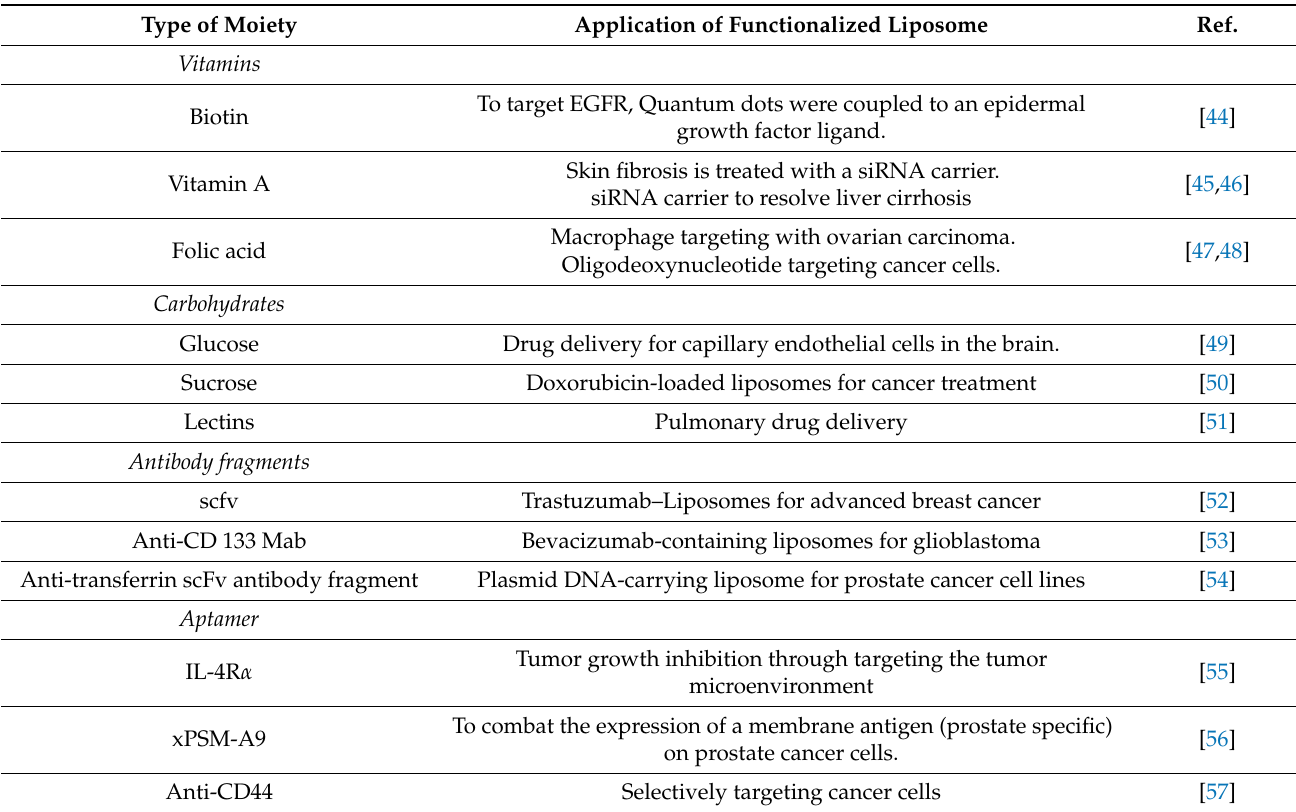
Table 1. Liposomes’ surface modifications with various moieties and their